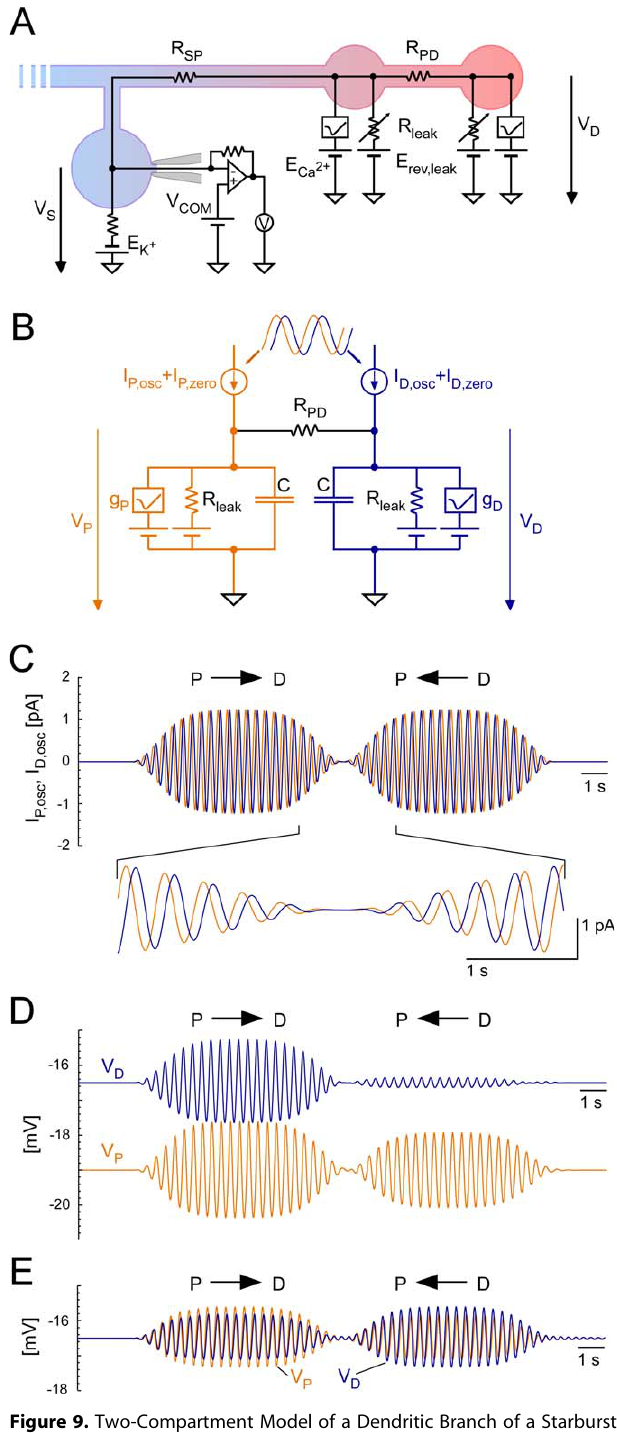
Figure 9. Two-Compartment Model of a Dendritic Branch of a Starburst Cell (A) Schematic of SAC electrotonics, illustrating the proposed gradient between dendritic and somatic voltages ( V D and V S ; red represents relative depolarization; see also Equation 1); circuit components: longitudinal resistors between soma and proximal compartment ( R SP ) and between proximal and distal compartment ( R PD ) , distal leak resistance ( R leak ) , a voltage-gated Ca 2 þ and the somatic K þ conductance (with respective reversal potentials E rev,leak , E Ca 2 þ , and E K þ ), and the patch- clamp amplifier. (B) The model consists of two identical dendritic compartments, P (proximal) and D (distal), that each contain in parallel a capacitor (C),